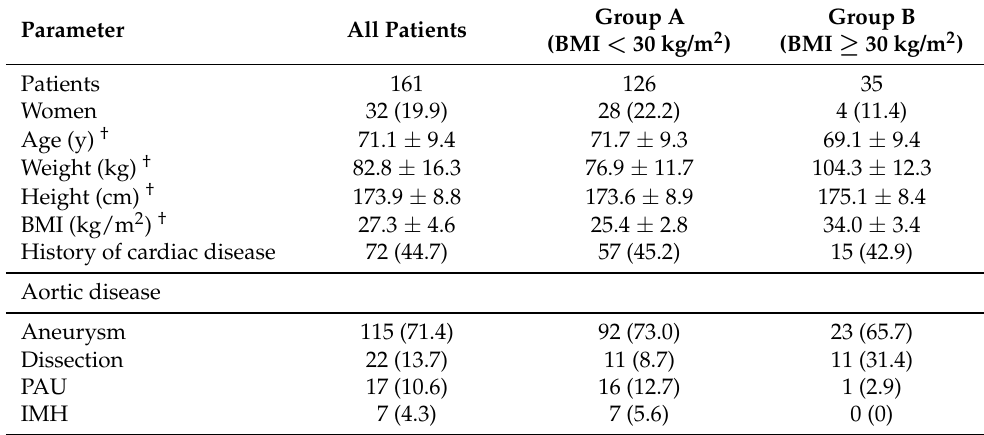
Table 2. Clinical characteristics of the study cohort.